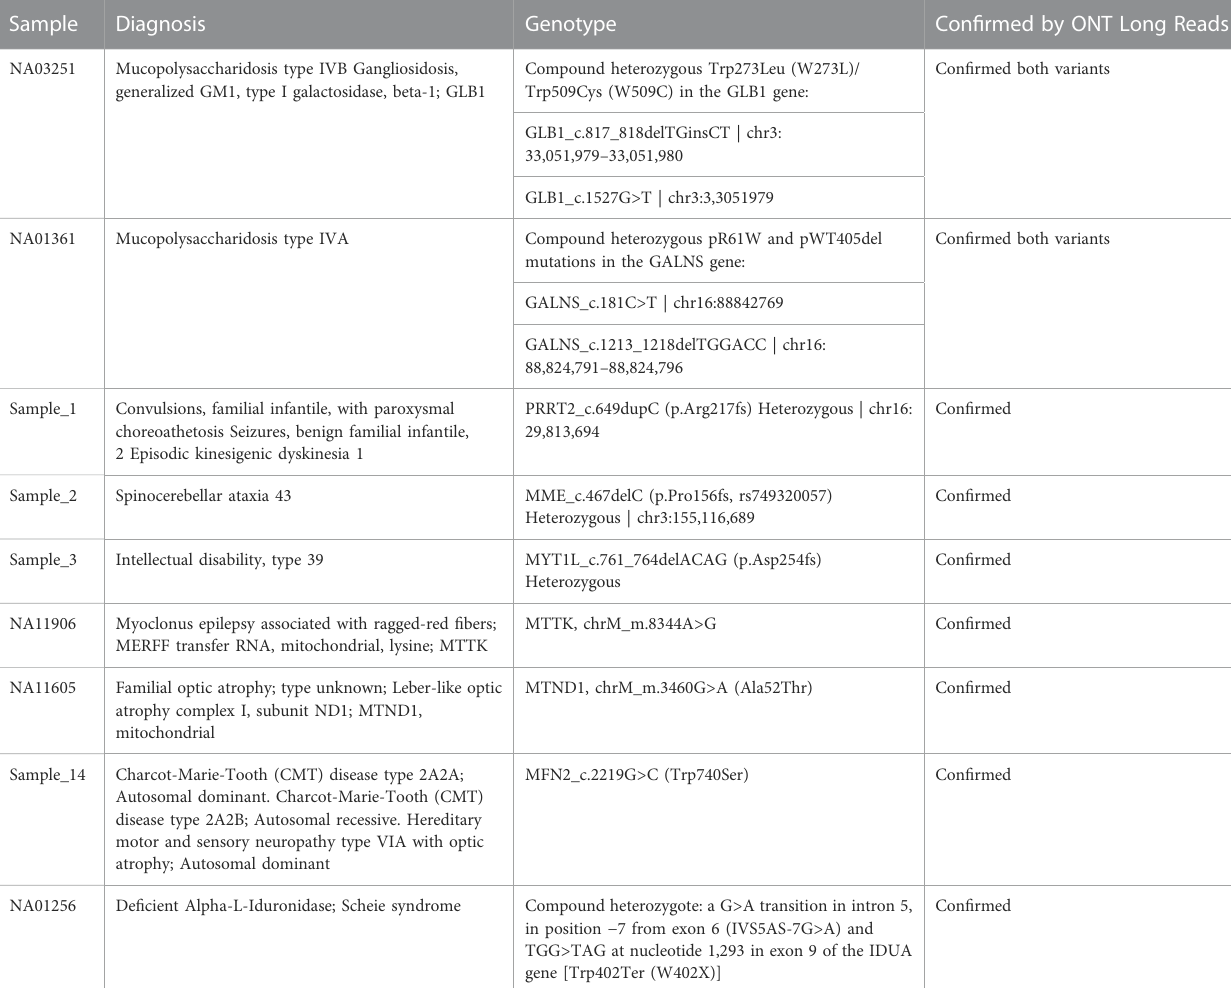
TABLE 2 Clinical validation of pathogenic Small Sequence Changes a (SSC) up to 50 bp detection with long read sequencing. Sample Diagnosis Genotype Con fi rmed by ONT Long